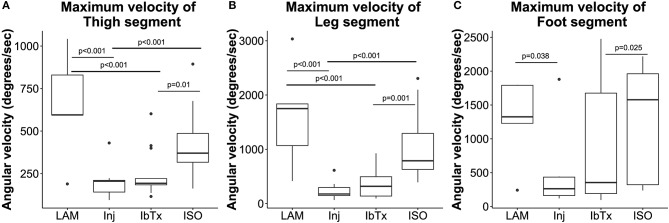
Improved neuro-protection translates to improved motor function in spinal cord injured rats treated with ISO. Eight weeks post-injury, 2D gait analysis was performed as described in Materials and Methods. Maximum velocity of thigh (A), leg (B), and foot (C) segment angles were assessed. Laminectomised rats and SCI rats treated with ISO had significantly greater ROM of thigh and leg segment angles compared to injured non-treated animals. There were no significant differences in foot segment angle velocity. Tukey box plots are shown. LAM n = 3; Inj = 6; IbTx = 6; ISO = 13.